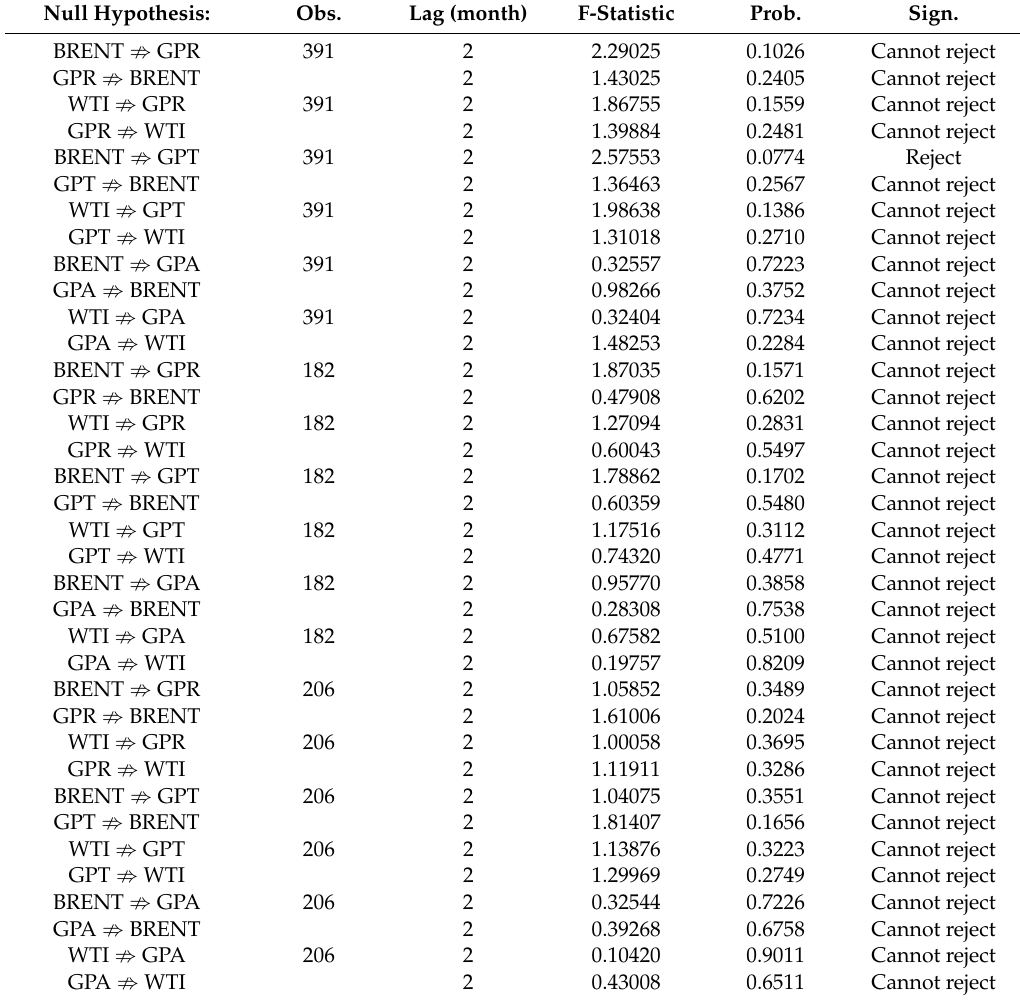
Table 4. Results of Granger causality test with first-order